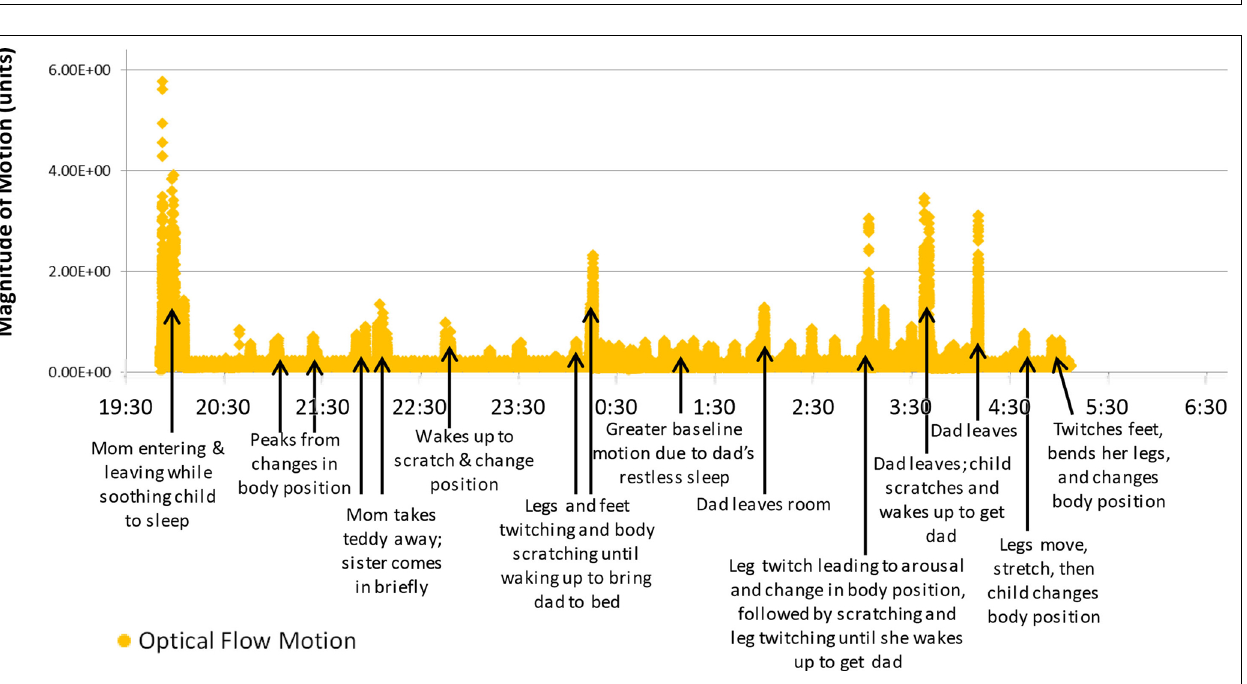
optical flow (in arbitrary units) is displayed on the vertical axis. Points of interest are labeled to show correspondence between sleep events and peaks of movement